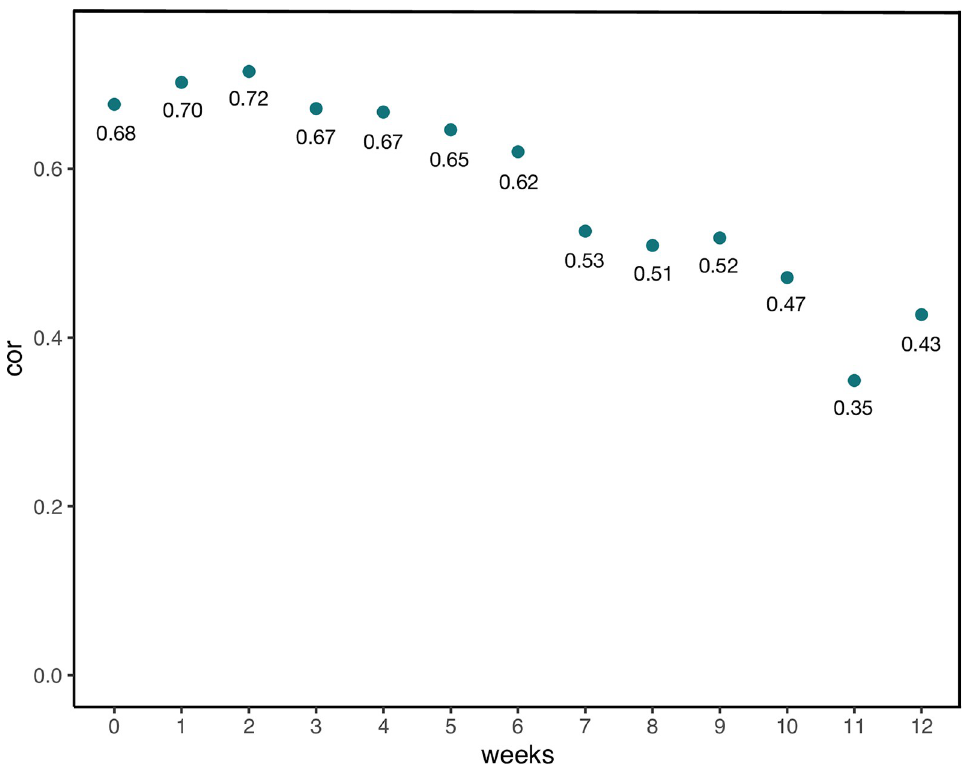
Fig 4. Change of correlation between distress and loudness over the study period (EMA). Pearson’s product-moment correlations between tinnitus distress and loudness during baseline phase (week 0) and intervention phase (week 1–12). All correlations are statistically significant ( p < .001). N =